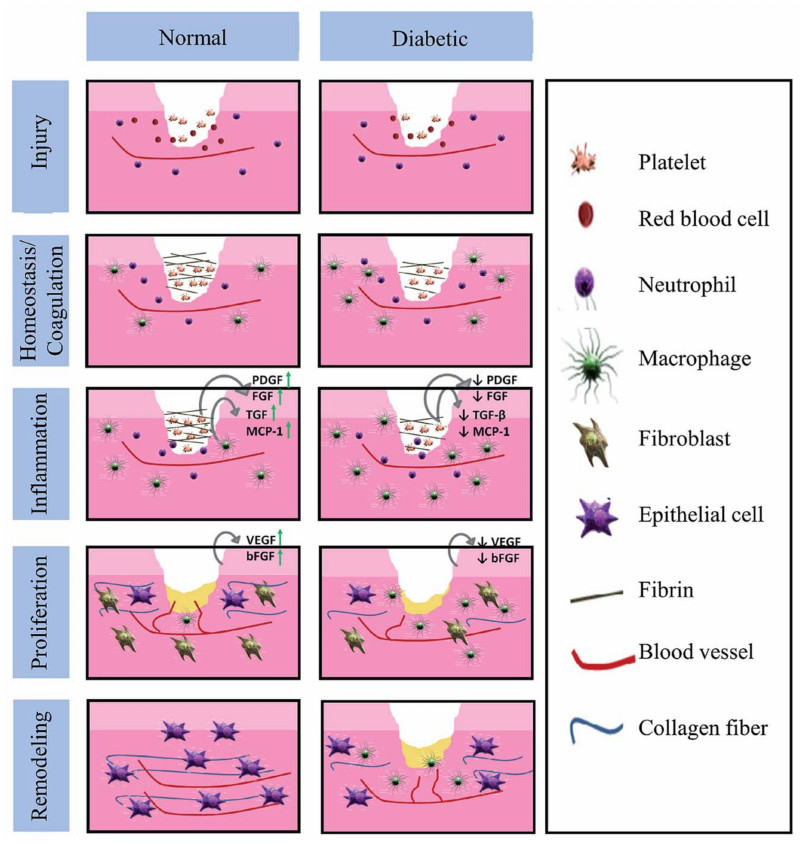
Figure 22. Differences in the wound healing phases between normal and diabetic persons. Reprinted from [65]. Copyright 2013 with permission from